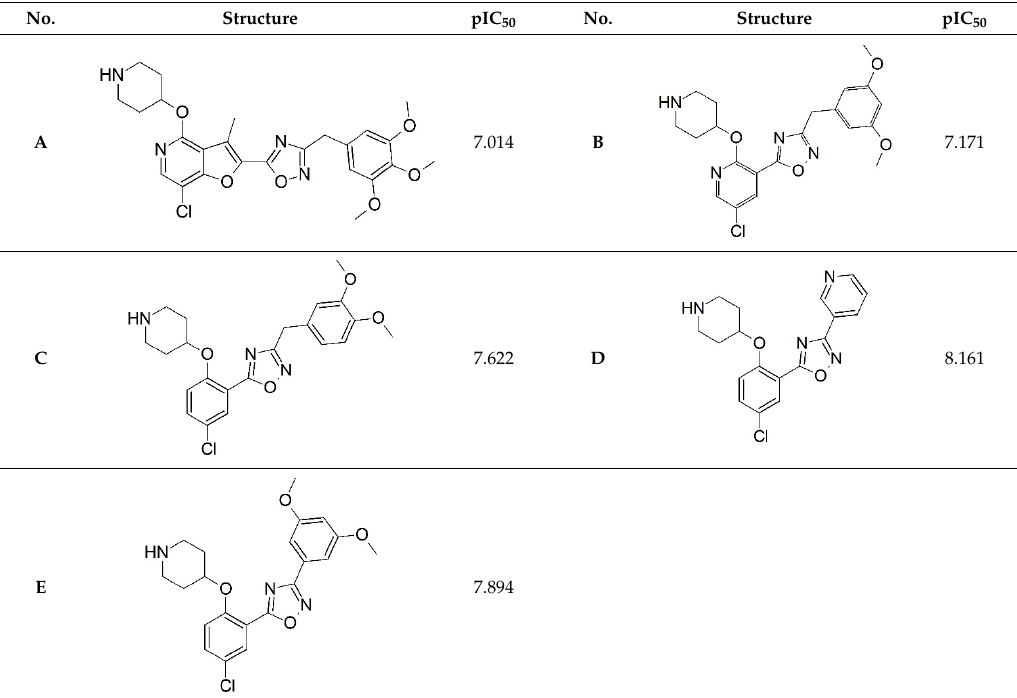
Table 4. Calculated parameters of the Lipinski rule of five for the proposed molecules. Molecule